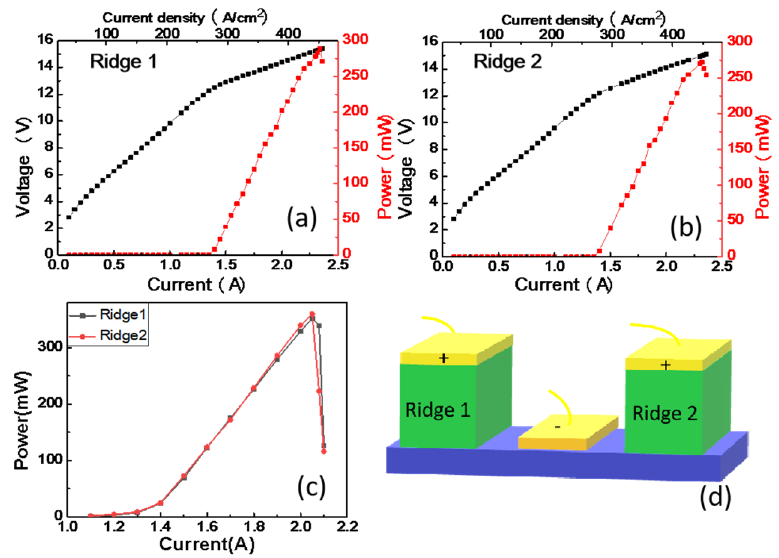
Figure 2. Typical P-I-V curves of each ridge in CW mode and in PW mode at 15 K. ( a ) P-I-V curve of Ridge 1 in CW mode; ( b ) P-I-V curve of Ridge 2 in CW mode; ( c ) P-I-V curves of two ridges in PW mode; ( d ) schematic diagram of the dual ridge THz QCL.